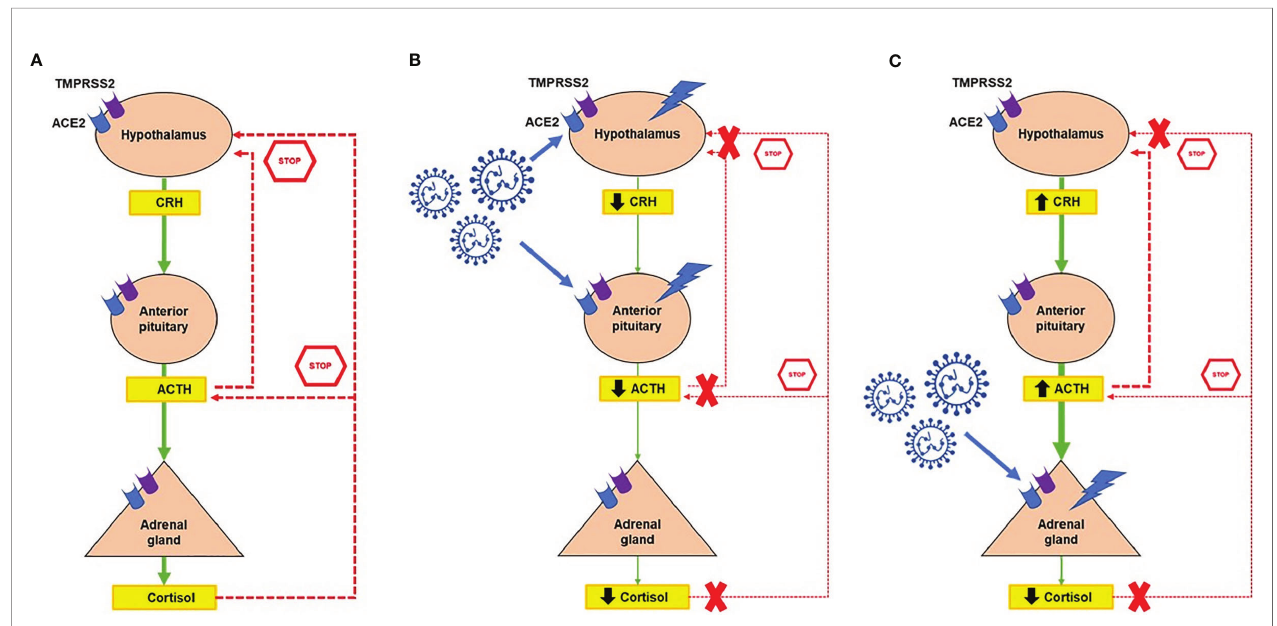
FIGURE 1 | Potential interaction between the hypothalamic-pituitary-adrenal axis (HPA) and SARS-CoV-2. (A) Normal function of the HPA axis in response to physiological cues and stress. The paraventricular nucleus of the hypothalamus releases corticotropin-releasing hormone (CRH), which stimulates the secretion of adrenocorticotropin hormone (ACTH) from the pituitary gland. Subsequently, ACTH stimulates the synthesis and release of cortisol from the adrenal cortex. In a negative feedback loop, cortisol inhibits further release of both ACTH and CRH, whereas ACTH inhibits CRH secretion. Angiotensin-converting enzyme 2 (ACE2) and transmembrane protease serine 2 (TMPRSS2) receptors are expressed at all levels of the HPA axis. (B) The hypothalamus and pituitary could be directly damaged by SARS-CoV-2, resulting in central hypocortisolism. (C) Direct damage of the normal adrenal gland secondary to SARS-CoV-2, which might result in primary adrenal insuf fi ciency. In all cases of adrenal insuf fi ciency, the negative feedback loop is compromised. Symbols: ↑ , increased; ↓ ,